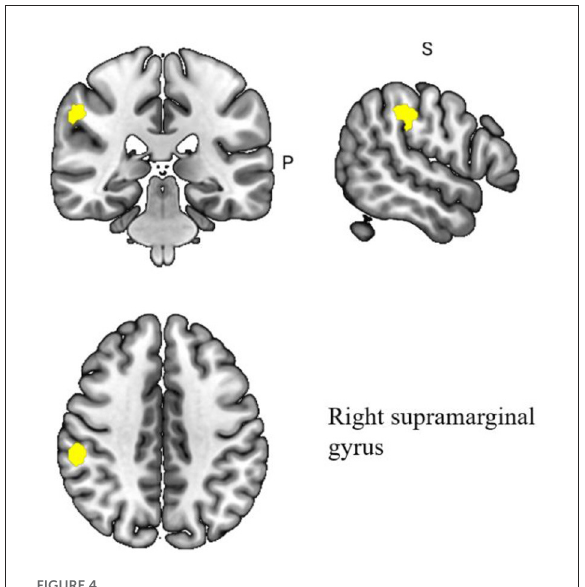
FIGURE4 Regional differences in gray matter between MCI patients and healthy controls after acupuncture treatment.